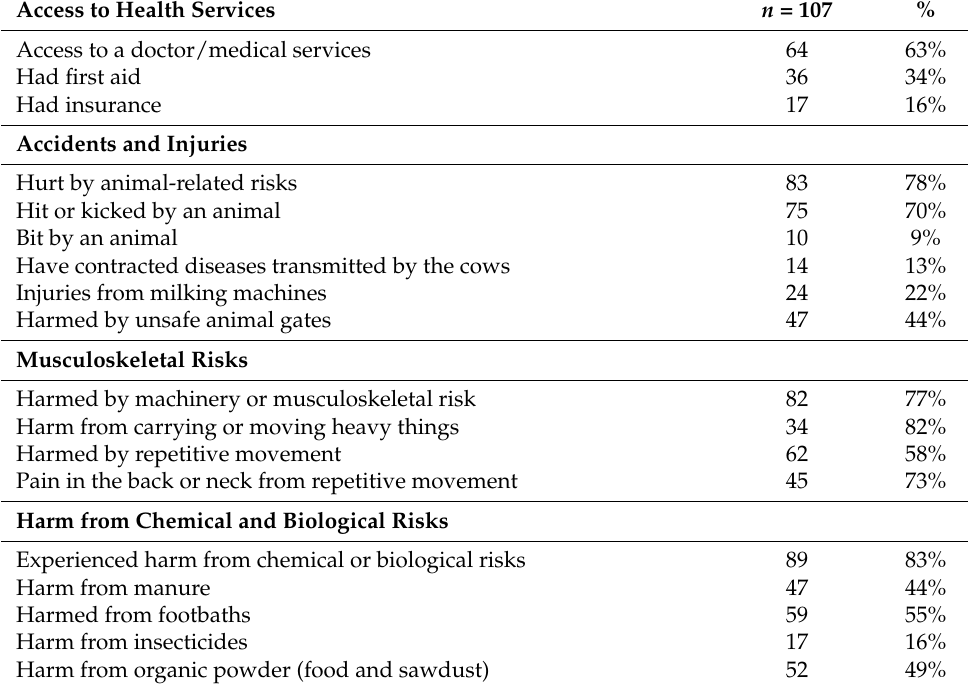
Table 2. 2019 Health and Safety Survey: Health risks in Vermont dairy